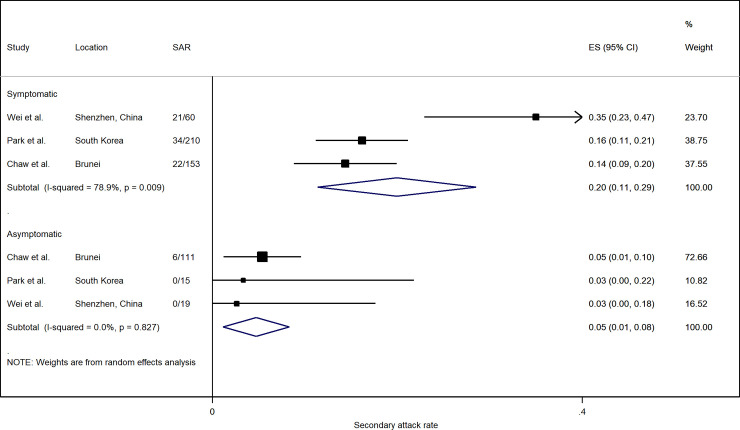
Forest plot of household secondary attack rates (SAR) by symptom status of index case.ES is the estimated SAR, with 95% confidence intervals (CI). I-squared is the percentage of between-study heterogeneity that is attributable to variability in the true effect, rather than sampling variation.